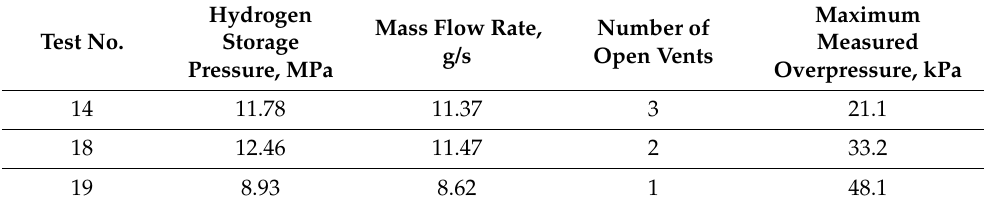
Table 1. The USN experiments for the CFD model validation.